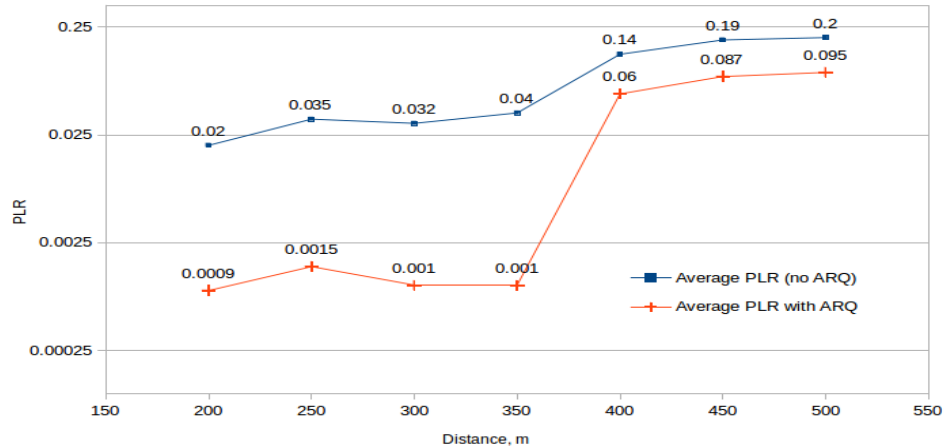
Figure 9. Average packet loss rate (PLR) measured in relation with distance.